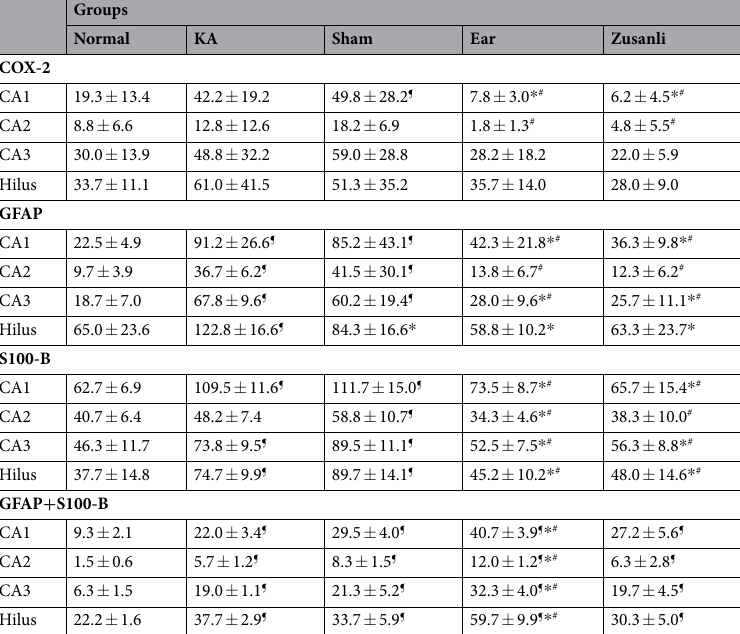
Table 1. Effect of electrical stimulation at the ear and electro-acupuncture at ST36–ST37 on COX-2, GFAP, and S100-B immunoreactive cells in kainic acid-induced epileptic seizure rats. Data represented as mean ± standard deviation; Normal: normal group; Sham: sham group; Ear: auricular group; Zusanli: Zusanli group; KA: kainic acid group; COX-2: cycloxygenase-2 immunoreactive cells; GFAP: glial fibrillary acidic protein immunoreactive cells; S100-B: S100-B immunoreactive cells; CA1: CA1 region of the hippocampus; CA2: CA2 region of the hippocampus; CA3: CA3 region of the hippocampus; Hilus: hilus region of the hippocampus; ¶ p < 0.05 compared with the value of Normal; * p < 0.05 compared with the value of KA; # p < 0.05 compared with the value of Sham; n = 6.